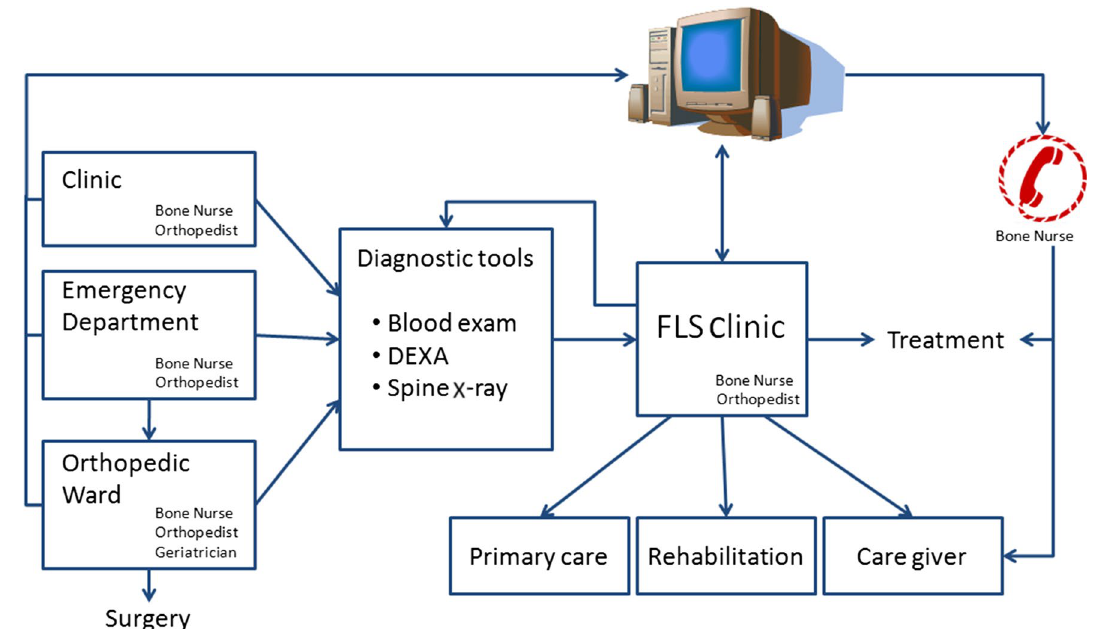
Fig. 7 Model of a fracture liaison service